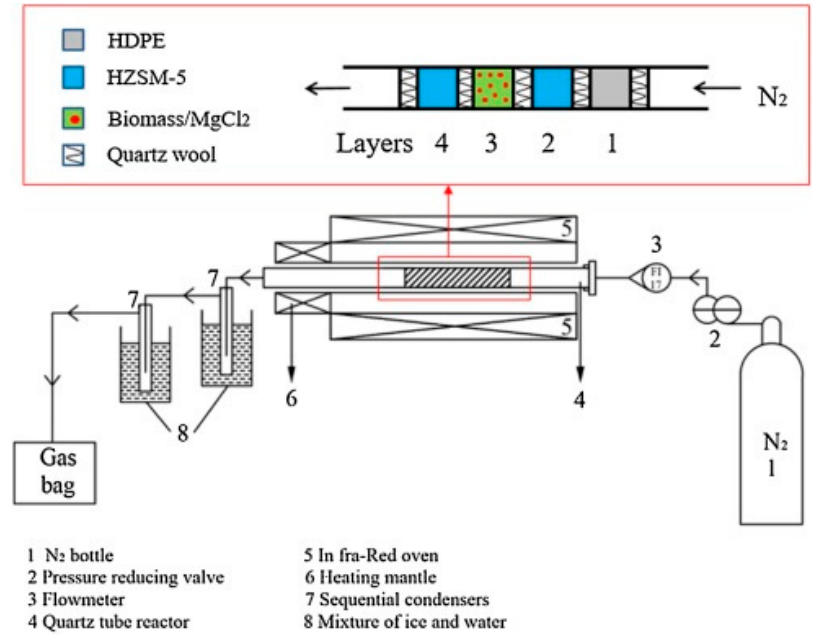
Figure 3. Schematic of the pyrolysis system for the catalytic co-pyrolysis of glucose and high density polyethylene (HDPE), reproduced with permission from [252]. Copyright Elsevier, 2018.